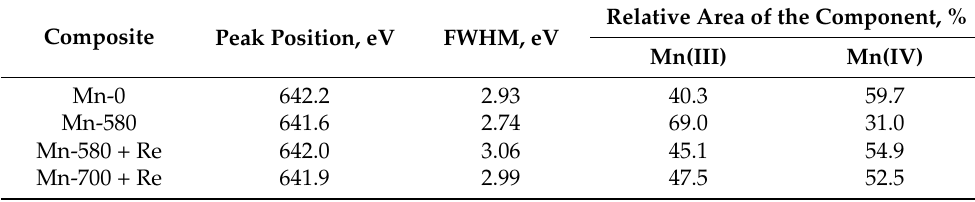
Figure 4. Mn 2p PE spectra of the composites: Mn-0 ( a ), Mn-580 ( b ), Mn-580 + Re ( c ), Mn-700 + Re ( d ). Table 3. Results of the analysis of Mn 2p PE spectra of composites.